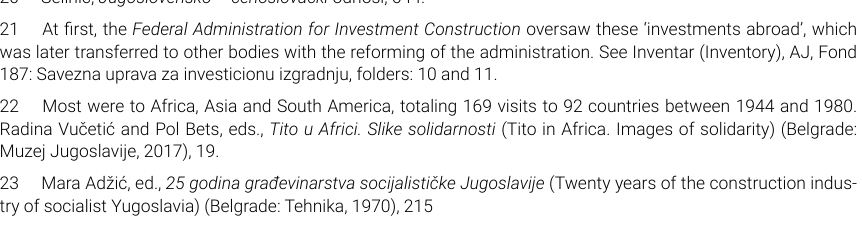
Fig. 4 Factory construction site in Mladá Boleslav, Czech Republic, n.d. (Source: Museum of Science and Technology,